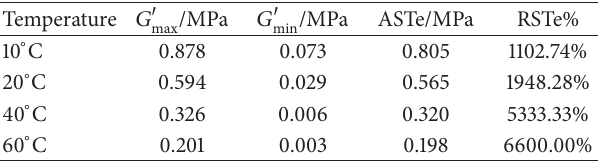
Table 2: 𝐺 󸀠 max , 𝐺 󸀠 min , ASTe, and RSTe% of MRSP-4 in the angular frequency scanning test at different temperatures.